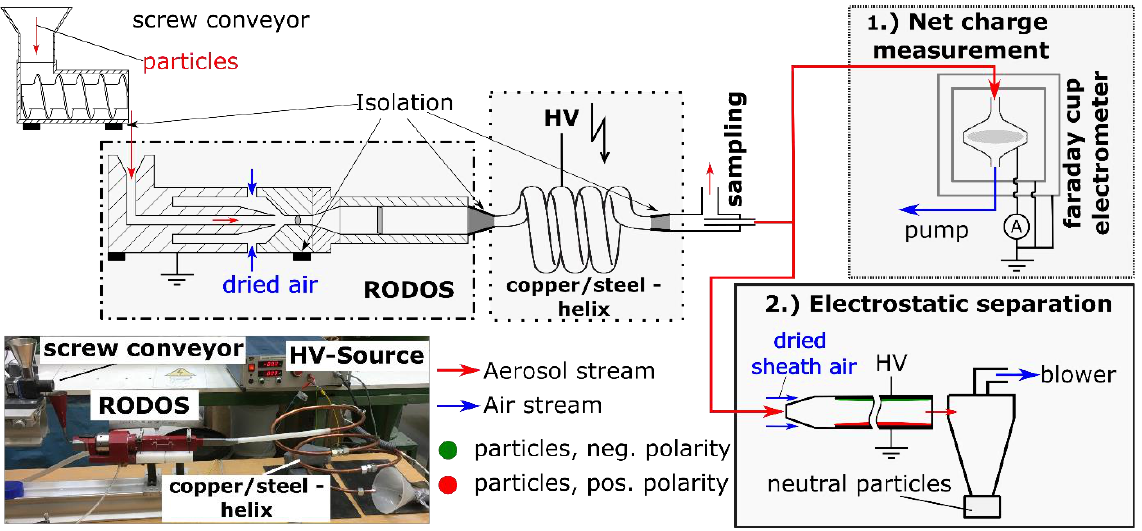
Figure 3. Experimental setup. The particles are suspended in a carrier gas (dried air) by a dispersing unit and charged by a copper or stainless-steel helix to analyze the ( 1 ) net charge and ( 2 ) charged and neutral fractions of the particles via an electrostatic precipitator.